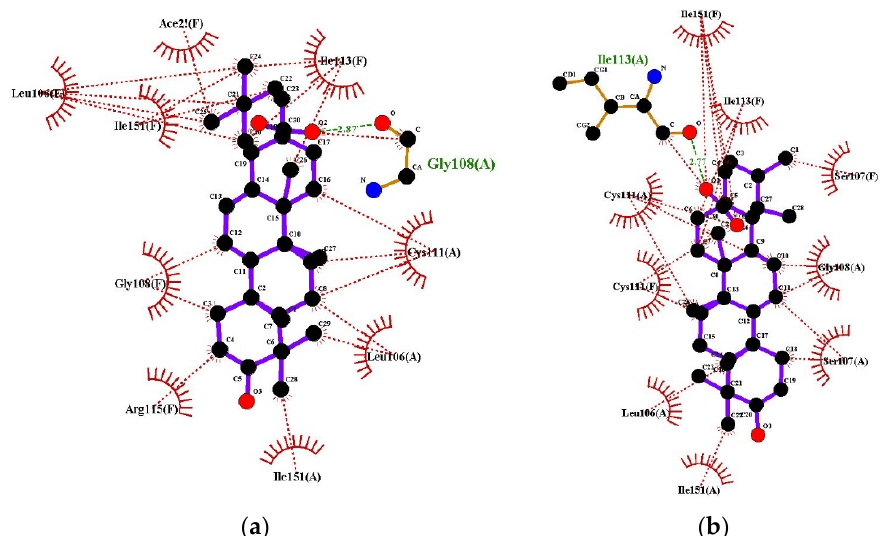
Figure 6. Ligplots showing interacting residues of Superoxide Dismutase (SOD1) in complex with